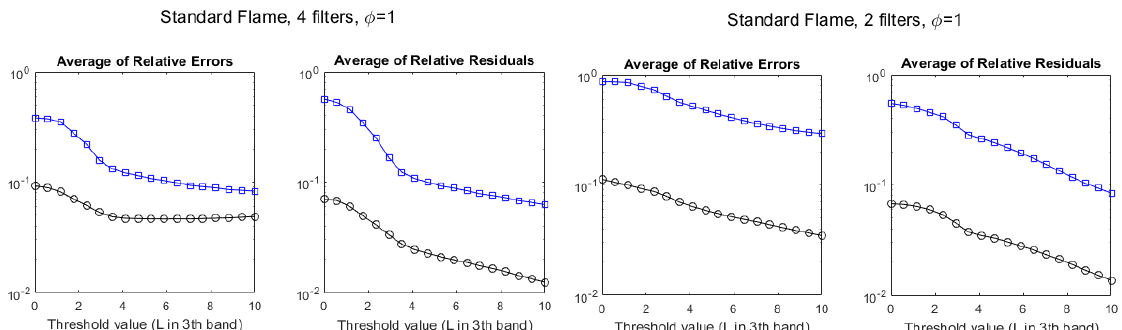
Figure 14. Evolution of the discrepancies between hyperspectral and multispectral temperatures (black circles) and column densities (blue squares), measured as average relative error and average residuals, for the standard stoichiometric flame, as a function of the radiance threshold, measured in W/m 2 · sr · cm − 1 . Left : values retrieved with four filters. Right : values retrieved with two